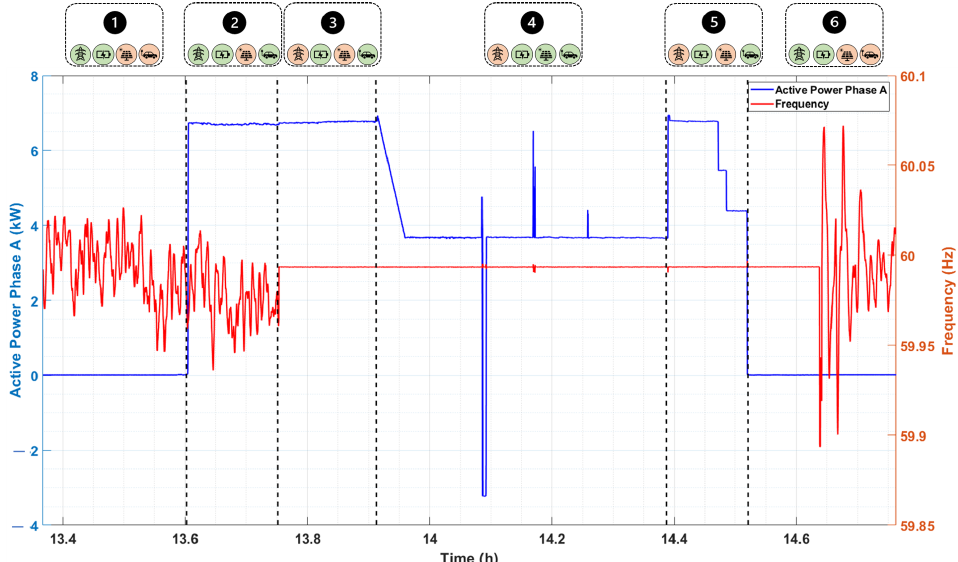
Figure 6. Active power and system frequency collected by power analyzer.